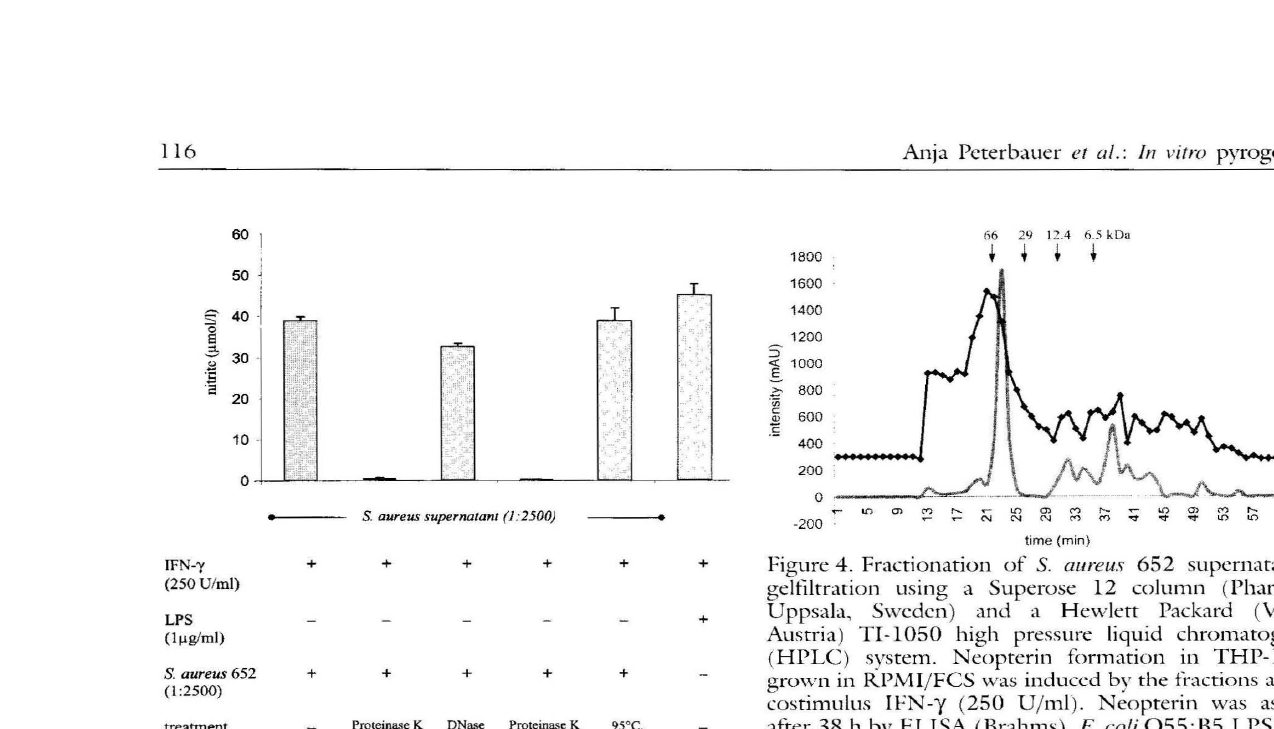
with heat (95°C for 10 min) or digested (37'C for